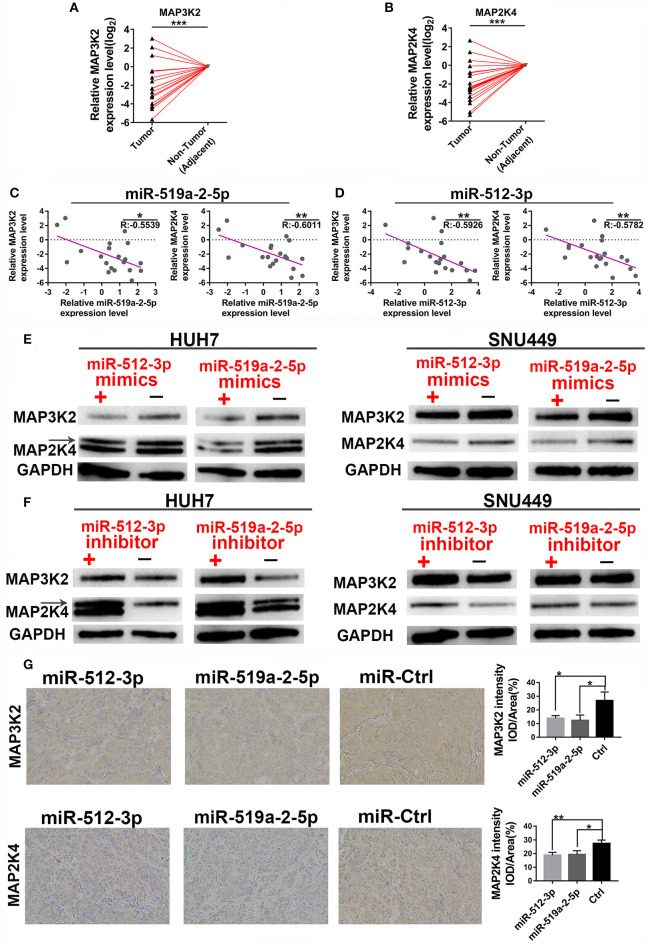
MiR-519a-2-5p and miR-512-3p co-targeted the expression of MAP3K2 and MAP2K4. (A,B) The expression of MAP3K2 (left) and MAP2K4 (right) in 20 paired HCC and adjacent non-tumor tissues. The expression levels in adjacent non-tumor tissues were normalized and set as 0. P-values were calculated with the Student's paired t-test. (C,D) The inverse correlation between the expression level of miR-519a-2-5p (C) and miR-512-3p (D) with MAP3K2 and MAP2K4. “R” represented the Pearson correlation coefficient. (E,F) Western blot analysis of the MAP3K2 and MAP2K4 expression in the HUH-7 and SNU-449 which were transfected with miR-519a-2-5p or miR-512-3p mimics (upper layer), inhibitor (lower layer) and their controls, respectively. (G) The immunohistochemical staining of MAP3K2 (upper layer) and MAP2K4 (lower layer) from the tumors tissues derived from miR-519a-2-5p, miR-512-3p-transfected LM3, and their controls. The statistics analysis was performed with the one-way ANOVA test. “*”, “**” and “***” represented the p-value < 0.05, 0.01 and 0.001, respectively.